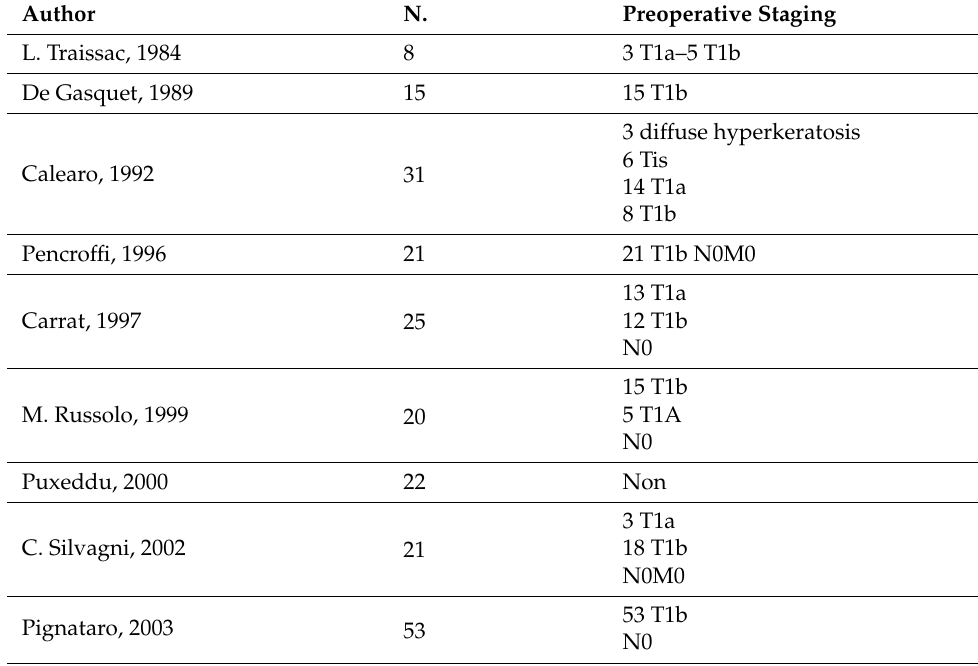
Table 1. Tumor preoperative staging. N. = number of